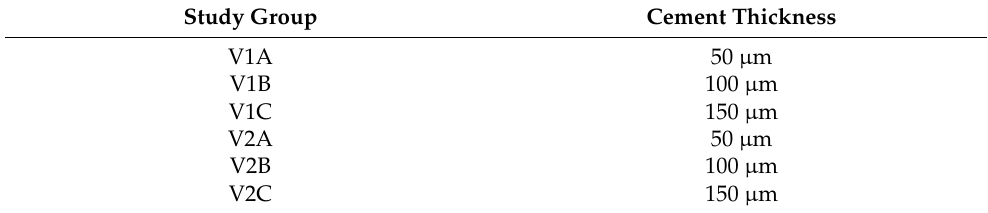
Table 2. Study groups.